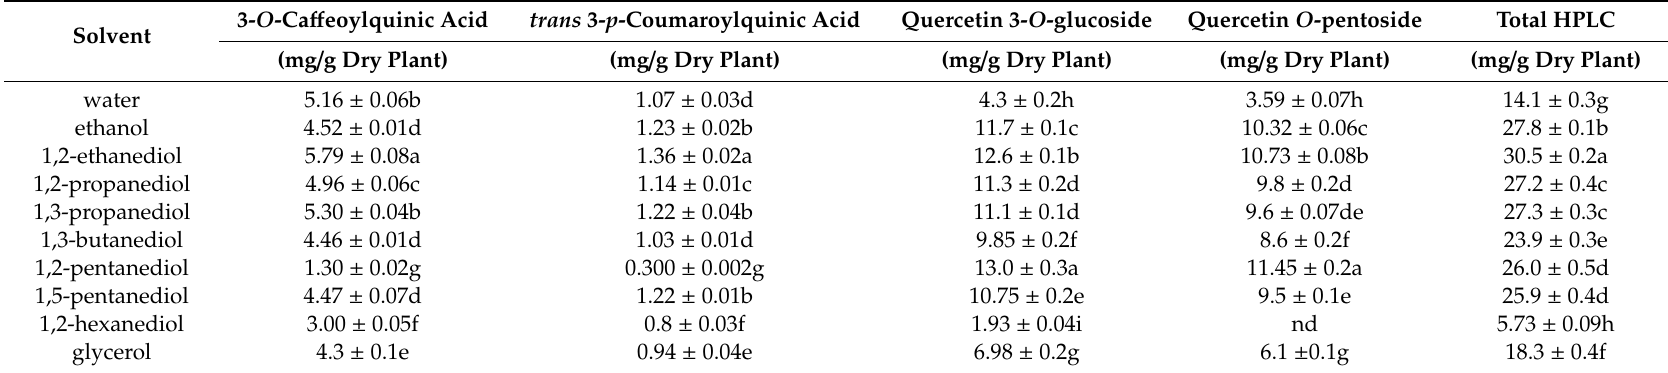
Table 2. Quantification of the main phenolic compounds present in di ff erent extracts of J. regia leaves (mean ± SD): 3- O -ca ff eoylquinic acid, trans 3- p -coumaroylquinic acid, quercetin 3- O -glucoside, quercetin O -pentoside, and total HPLC